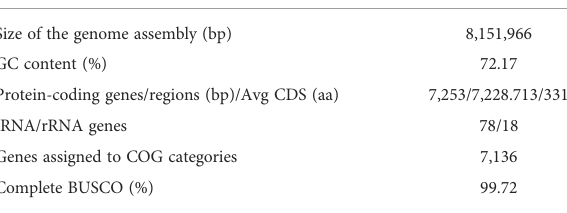
TABLE 1 Genomic features of Streptomyces sp.